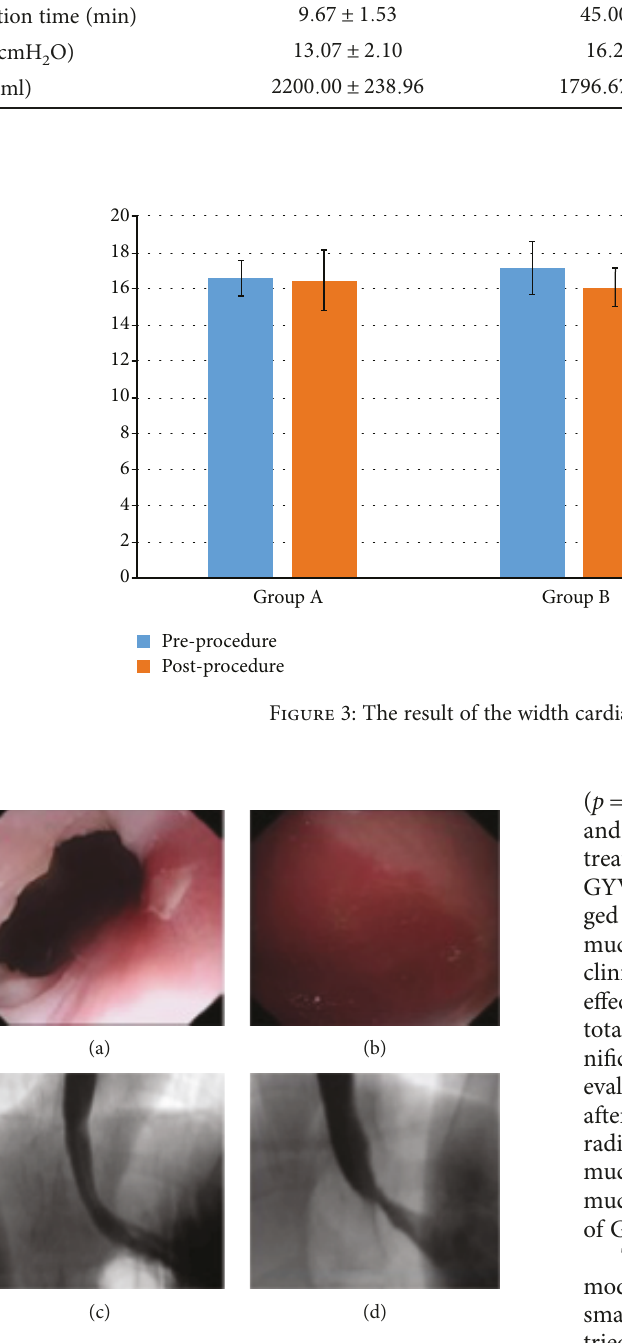
Figure 4: The result of endoscopy and barium radiography in group C: (a) esophageal mucosa at 6 weeks after ARMS; (b) stomach mucosa at 6 weeks after ARMS; (c) barium radiography before ARMS; (d) barium radiography after ARMS.